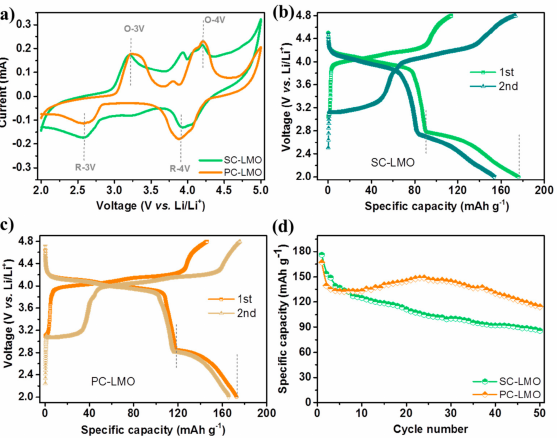
Figure 3. ( a ) CV curves of single-crystal LiMn 2 O 4 and polycrystalline LiMn 2 O 4 cathodes. GCD profiles of ( b ) single-crystal LiMn 2 O 4 and ( c ) polycrystalline LiMn 2 O 4 cathodes at 50 mA · g − 1 . ( d ) The cycle behaviors of single-crystal LiMn 2 O 4 and polycrystalline LiMn 2 O 4